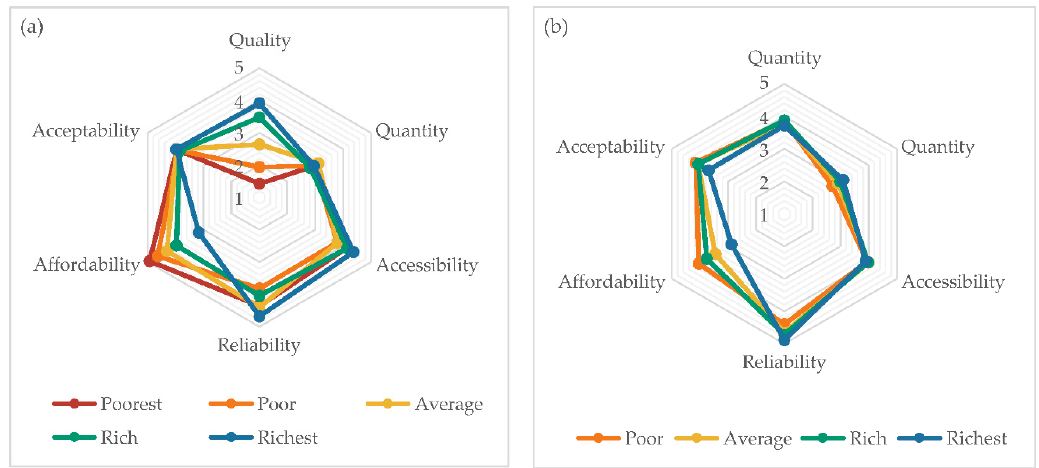
Figure 4. Household service level scores by rural wealth quintile for ( a ) Control and ( b ) Users; note: Both groups have a low sample size for the Poorest quintile—16 Control and one Intervention (excluded).